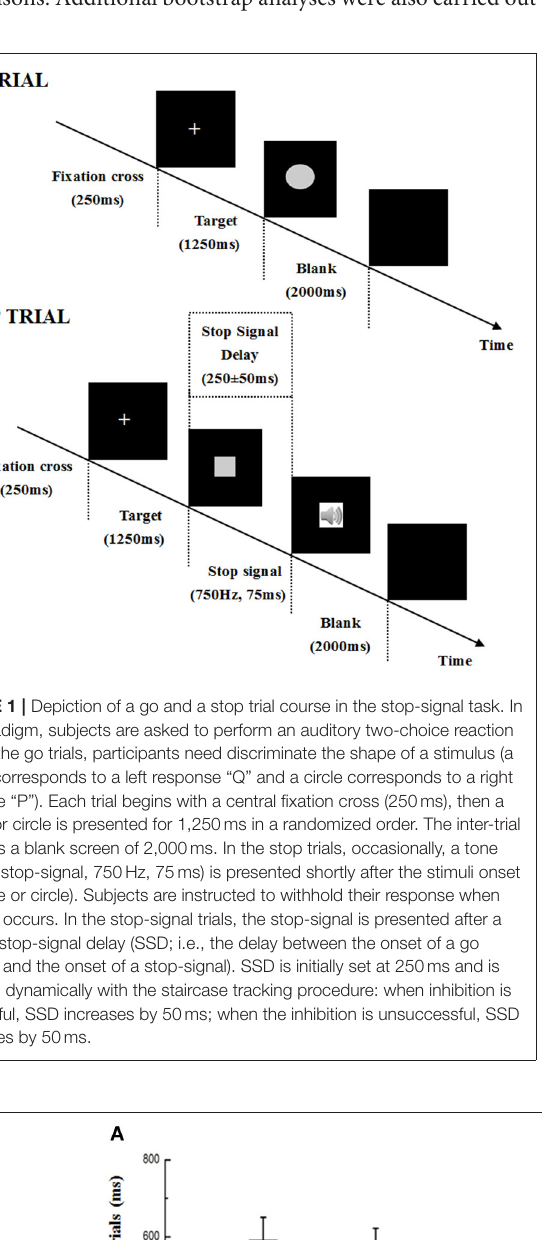
Frontiers in Neurology |